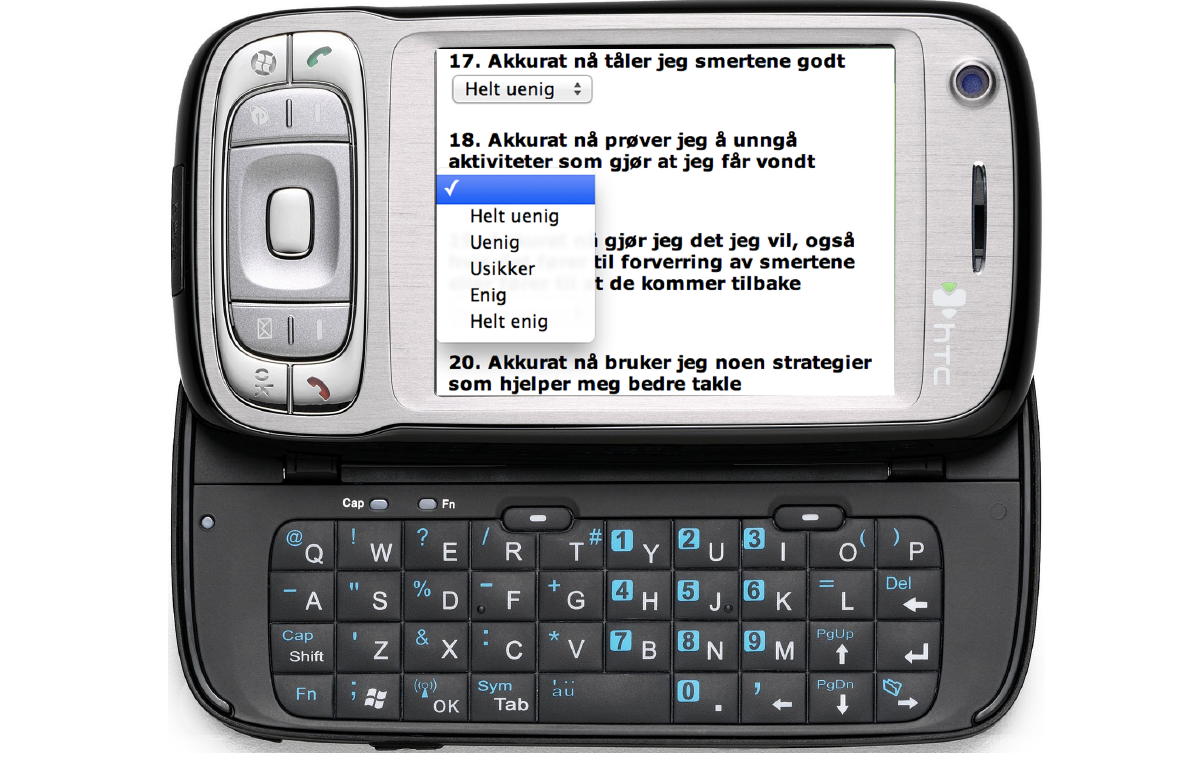
Figure 2. The smartphone's screen showing a diary in Norwegian.